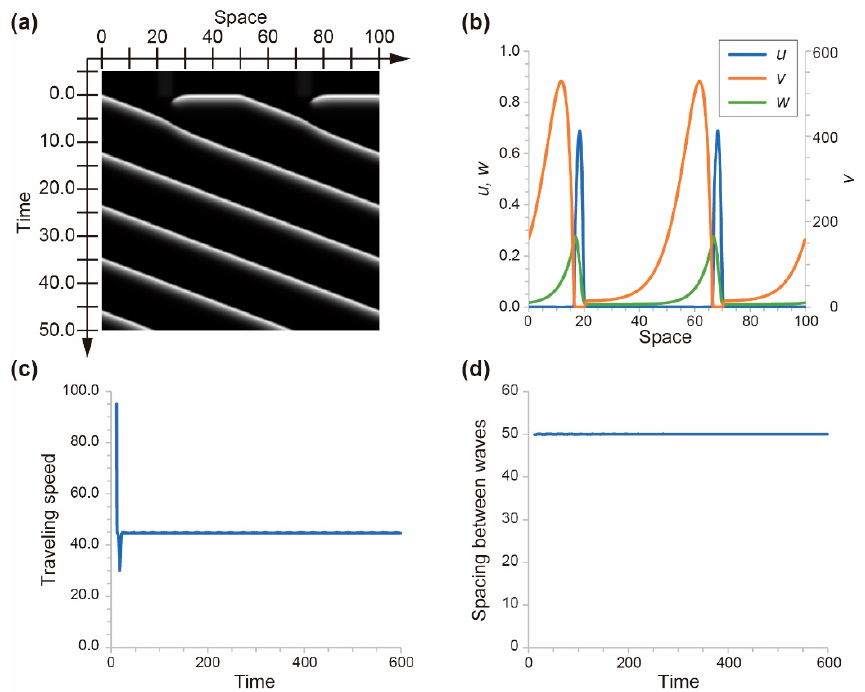
Figure 8. ( a ) Space–time diagram for the value of w . ( b ) Profiles of u , v , and w at t = 50.0. ( c ) Time series for the traveling speed of the wave. ( d ) Time series for the spacing between the waves.